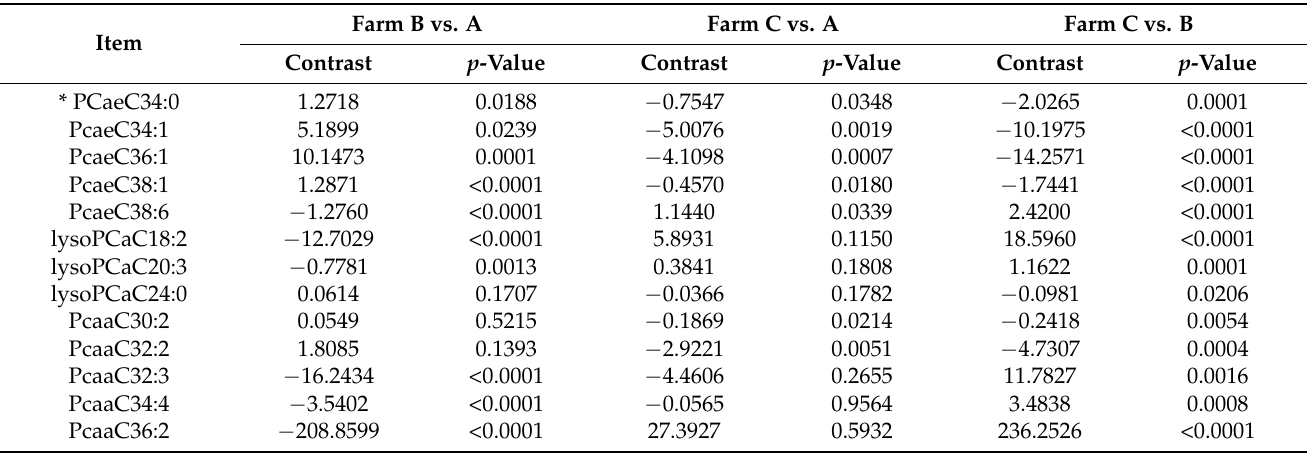
Table 6. Comparison of metabolomic parameters between Farms A, B, and C according to the non-parametric local–linear and the local–constant kernel regression model.